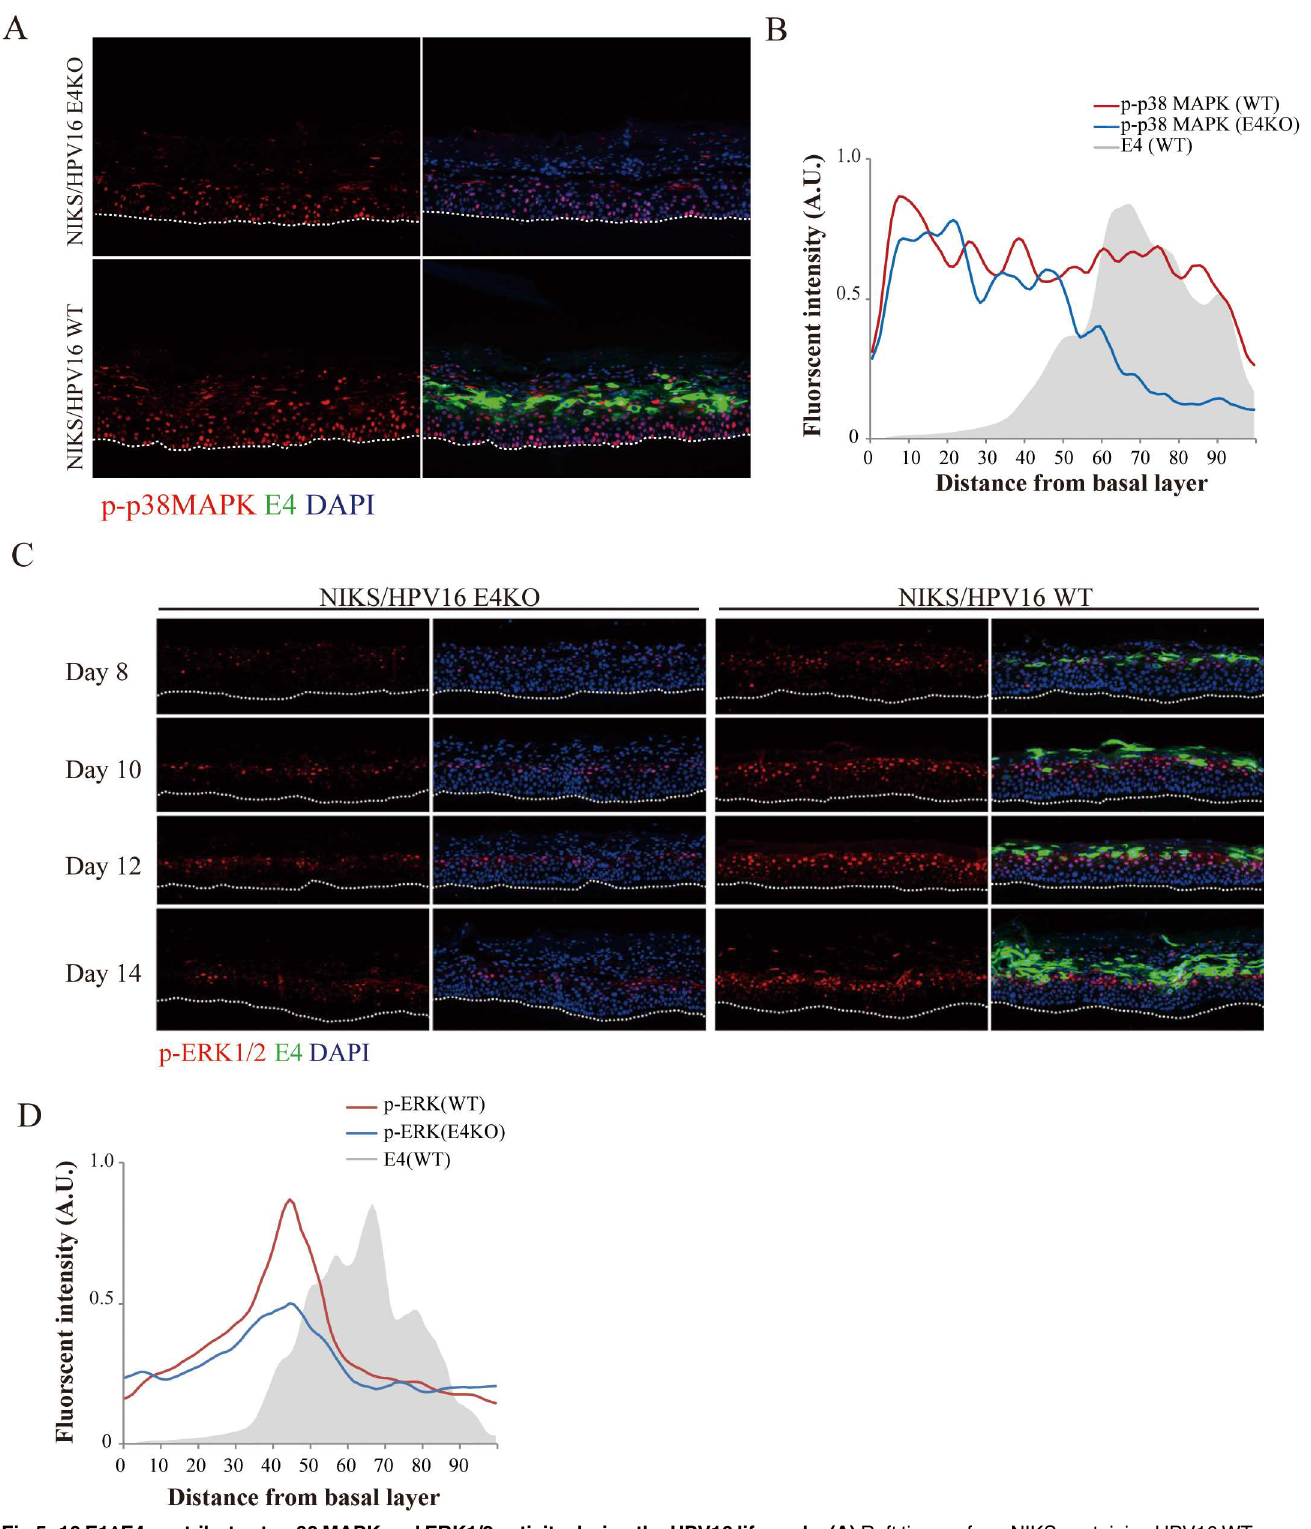
Fig 5. 16 E1^E4 contributes to p38 MAPK and ERK1/2 activity during the HPV16 life cycle. (A) Raft tissues from NIKS containing HPV16 WT or E4KO genomeswere harvested at day 14 post-differentiationand stainedfor 16E1^E4 (green), phospho-p38 MAPK (p-p38 MAPK) (red) and DNA (blue; DAPI). An elevationof p-p38 MAPK staining in the upper layers of the raft is apparentin rafts generatedusing the WT HPV16 genome.The dotted